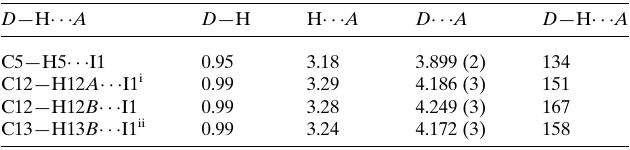
Figure 2 UV–Vis absorption ( a ) and fluorescence emission ( b ) spectra in solution (10 (cid:3) 5 M ). Table 1 Hydrogen-bond geometry (A˚ , (cid:4)